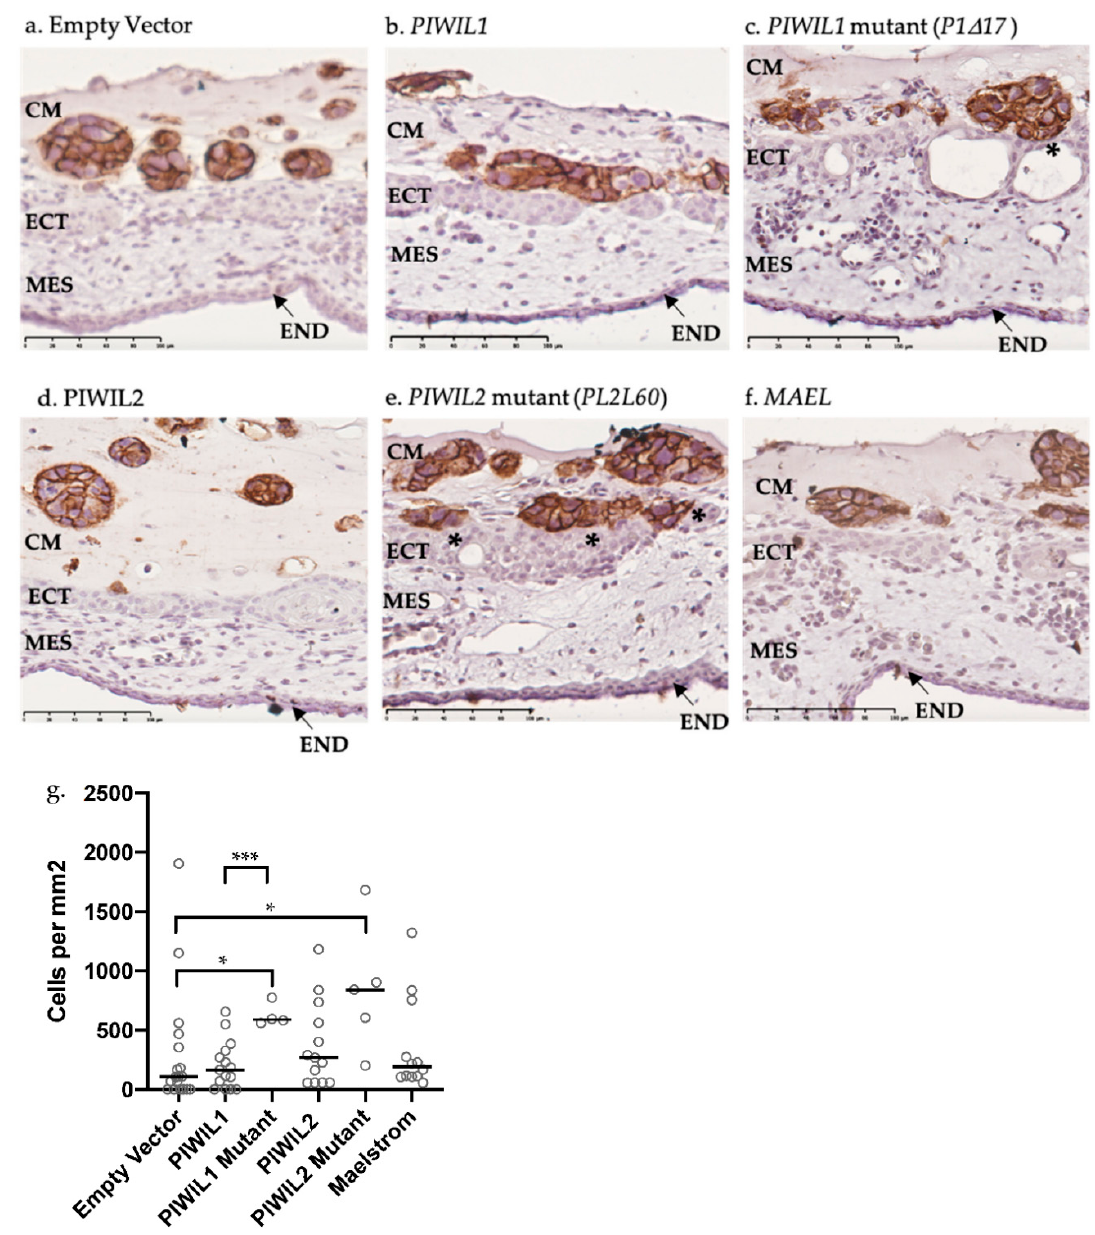
Figure 7. The in vivo invasion analysis using the chicken chorioallantoic membrane (CAM) assay. ( a – f ) CD44 stained OV-90 cells transfected with ( a ) empty vector (pcDNA3.1(+)) and overexpression constructs, ( b ) PIWIL1 , ( c ) P1 ∆ 17 , ( d ) PIWIL2 , ( e ) PL2L60 and ( f ) MAEL . CAMs were counterstained with haematoxylin. Invasion was quantified by the number of OV-90 cells that successfully breached the ECT and beyond (* marked next to breached area). CM = cancer cells mixed with matrigel, ECT = ectoderm, MES = mesoderm, END = endoderm. Scale bar = 100 µm. ( g ) Significantly more CAM area was invaded by P1 ∆ 17 and PL2L60 overexpressing OV-90 cells. Both mutants were more invasive than its respective wildtype form where only overexpression of P1 ∆ 17 was significant. n = 4–18 per construct transfected and carried out in biological duplicates. Statistical tests Mann − Whitney U (non-normal distribution) or unpaired t -test (normal distribution) were used accordingly. * p < 0.05; *** p < 0.0005.